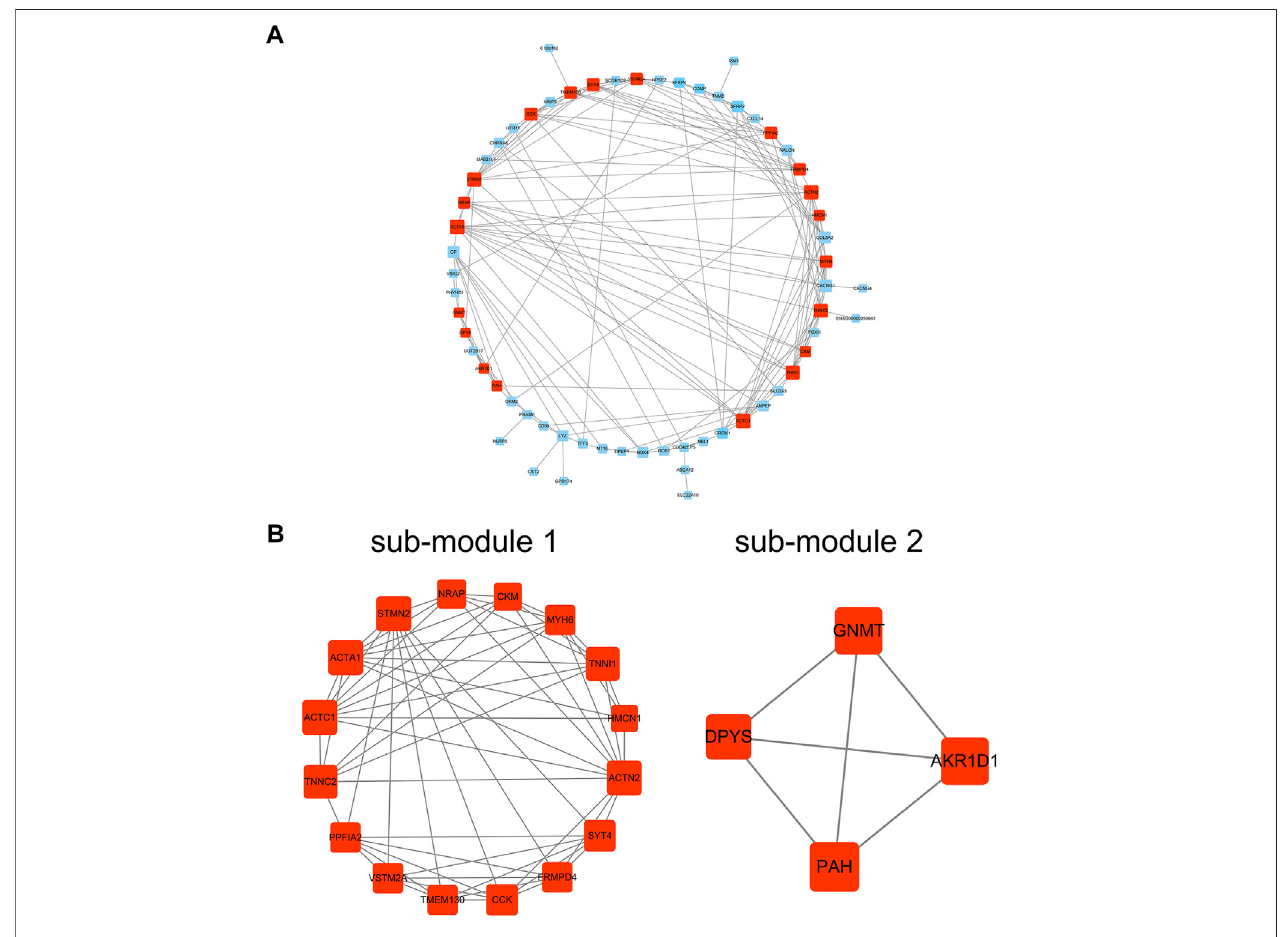
FIGURE 5 | PPI network analysis. (A) PPI network; (B) sub-module 1 and sub-module 2. PPI: protein – protein interaction.